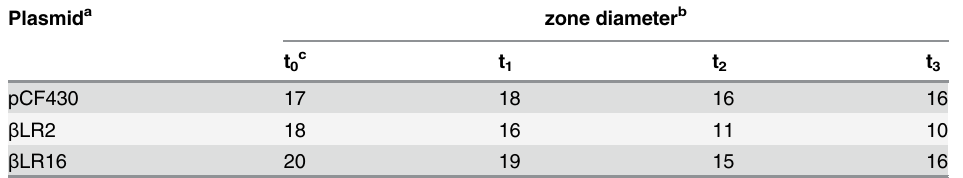
Table 4. Zones of inhibition of EPI300 E . coli growth resulting from 400 μ l supernatant following incubation with 100 μ g ml -1 carbenicillin. Plasmid